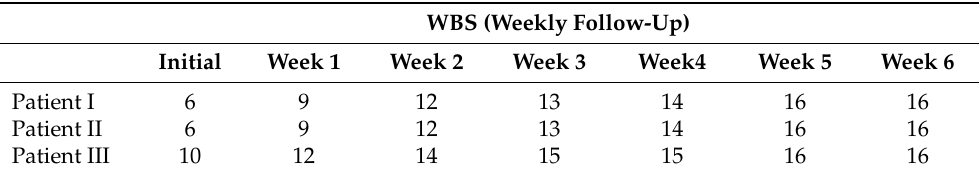
Table 2. WBS of the patients.